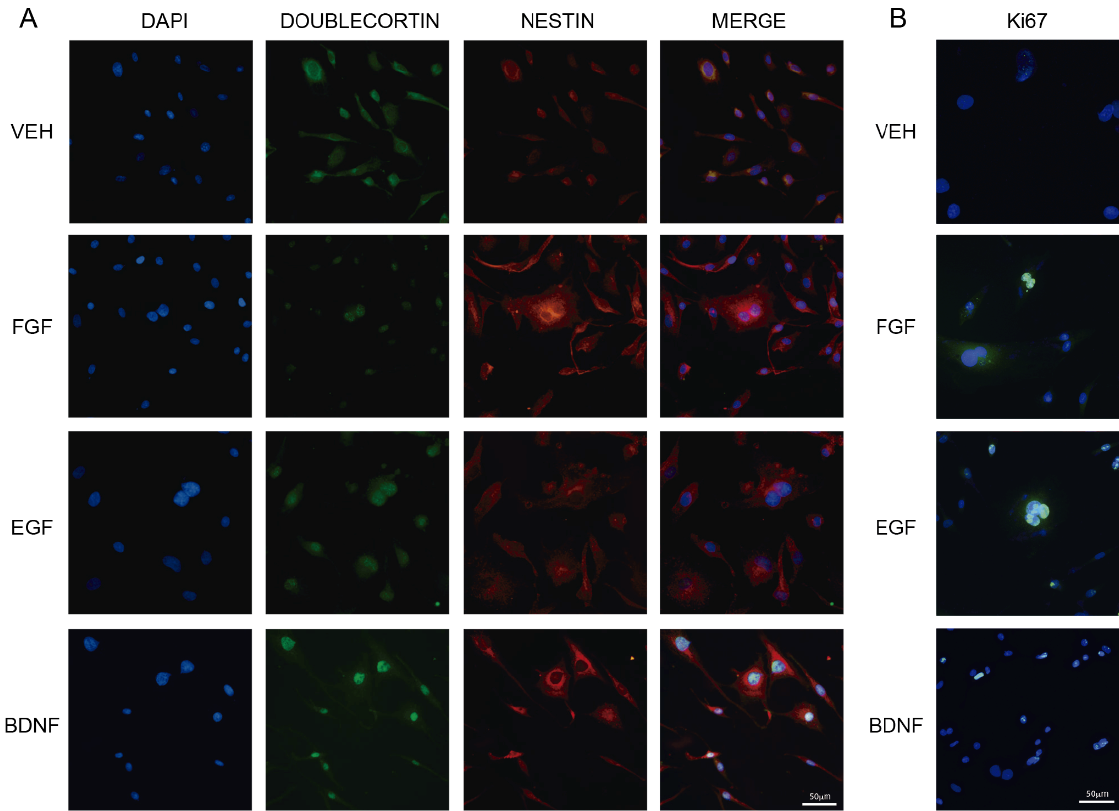
Figure 1. Growth factors elicits cluster formation in human olfactory neuronal precursors. ONPs were incubated during 6 h with 20 ng/mL of either fibroblastic growth factor (FGF), epidermal growth factor (EFG), brain-derived neurotrophic factor (BDNF) or the vehicle (VEH). Then, cells were fixed and stained with anti-doublecortin and anti-nestin antibodies, followed by secondary antibodies coupled to FITC (green) and RITC (red), respectively. Representative images are shown in Panel A . Another group of cells was stained with DAPI and an anti-Ki67 antibody, followed by a secondary antibody that recognizes the anti-Ki67 antibody (Panel B ). Scale bar = 50 µm.